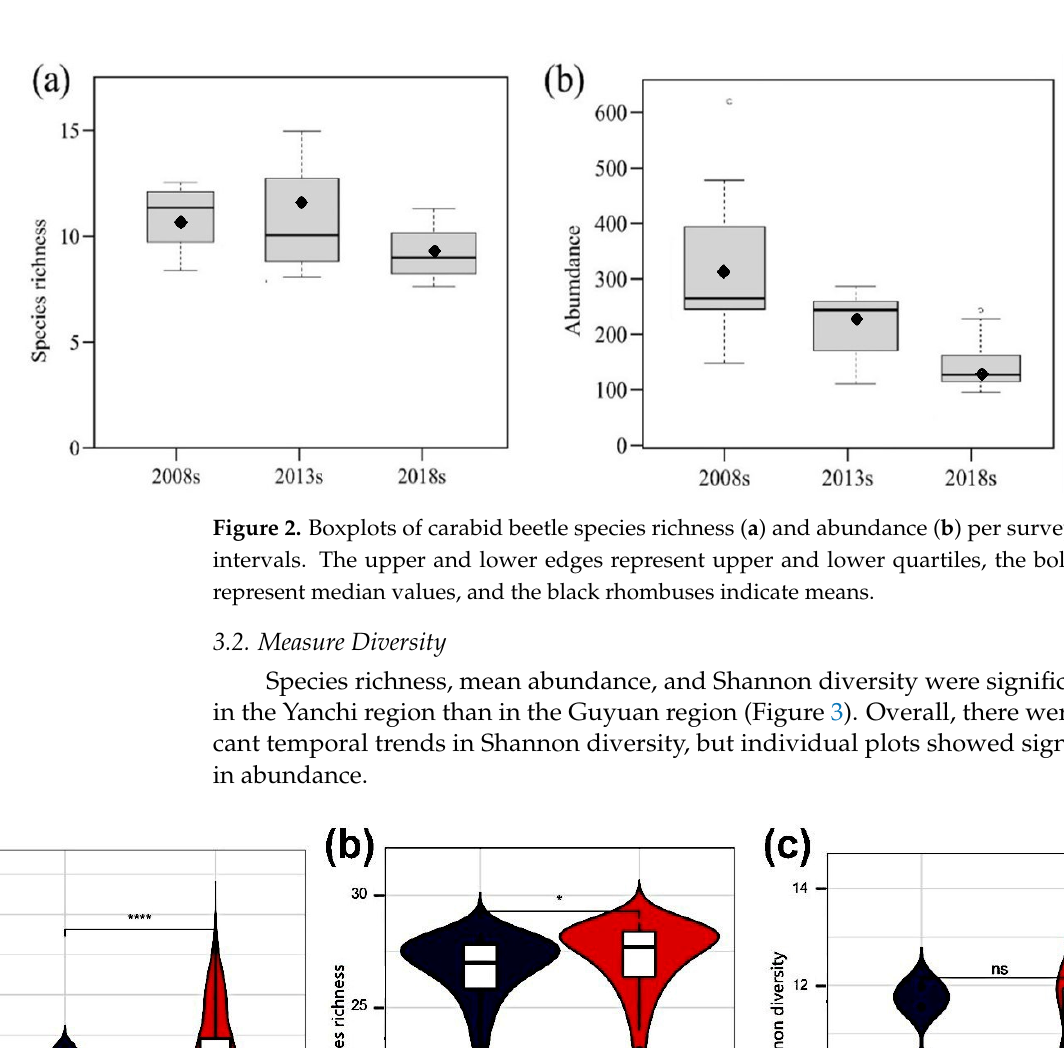
Dashes indicate variables that did not contribute to the models and were thus excluded.